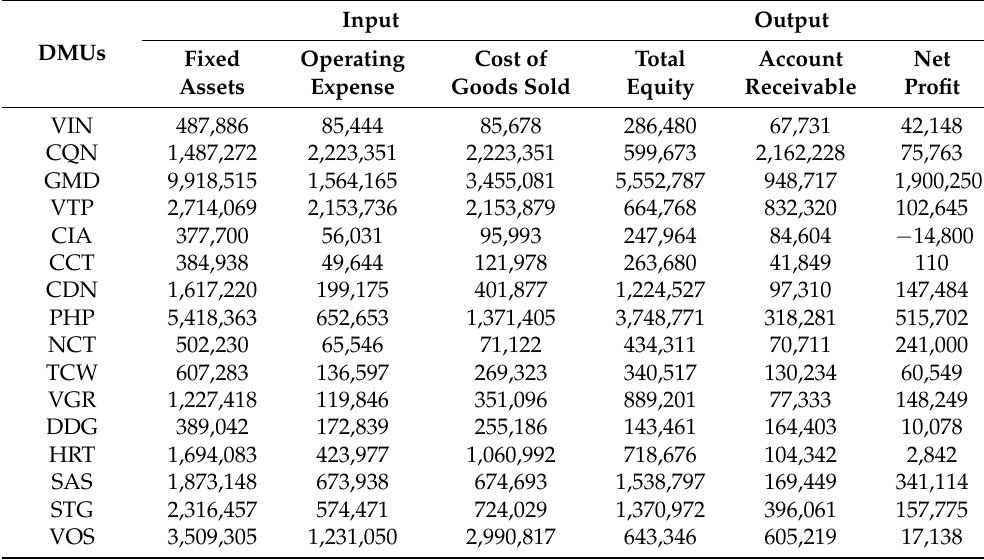
Table 4. The data of Vietnam logistics company 2020 (Unit: million dong).